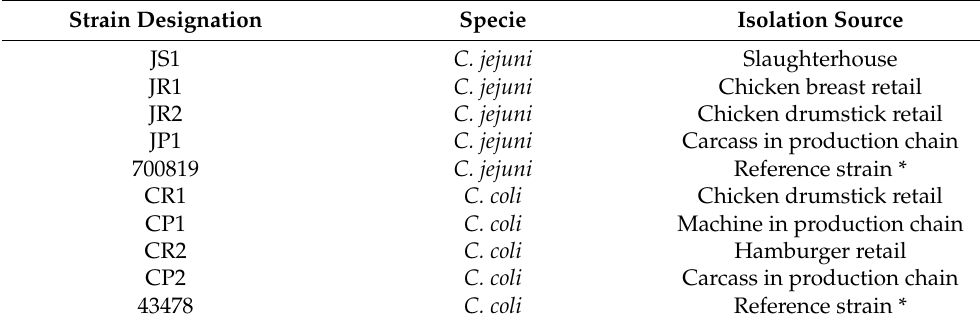
Table 5. Summary of Campylobacter spp. strains isolated from different stages of the chicken food chain and collection strains used in the present study.